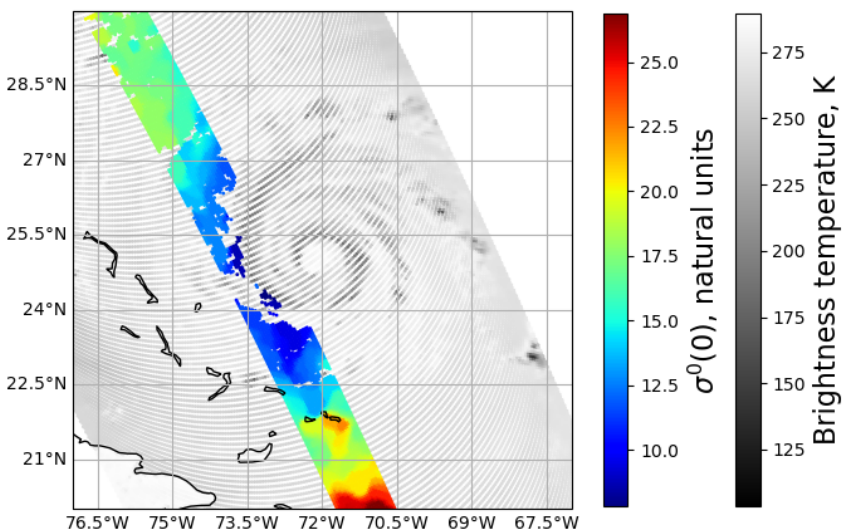
Figure 2. “Nadir normalized radar cross section (NRCS)” over the image of brightness temperature from the GMI data at 89 GHz, V-polarization, Hurricane Maria at 12:15 UTC on 23 September 2017.